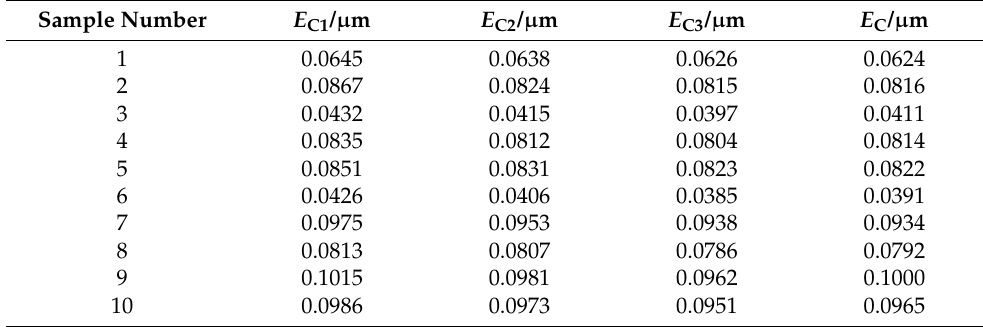
Table 3. Roundness error calculation